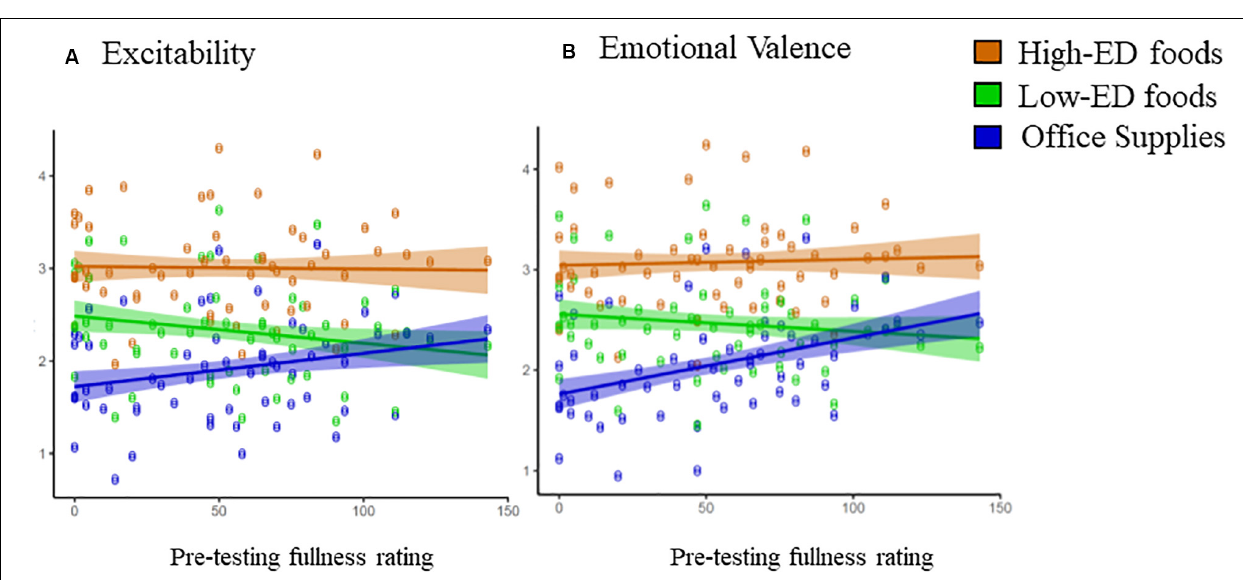
FIGURE 4 | Children’s recognition of 30 high-ED food images. 30 low-ED food images. and 30 office supply images between Image Set 1 and Image Set 2 of the images. Improvements in image recognition were attributable to improvements made in recognition of low-ED foods and office supplies not high-ED foods [version × image category interaction term: P < 0.000 1: F (2gg) = 12.53].